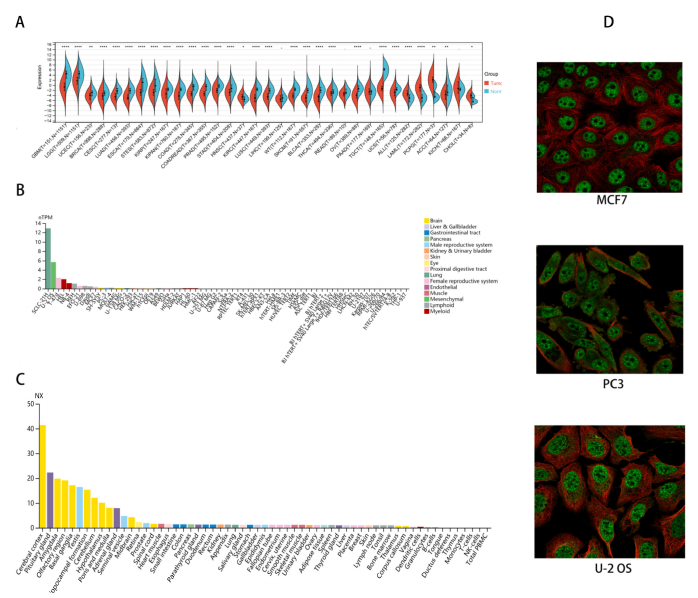
Figure 1. Pan-cancer analysis of CHD5 expression. ( A ) Differential expression of CHD5 between tumor and normal tissues in pan-cancer analysis. ( B , C ) Expression of CHD5 in various cancer cell lines. ( D ) Cellular localization of CHD5 ( p < 0.05). * p < 0.05; ** p < 0.01, **** p <